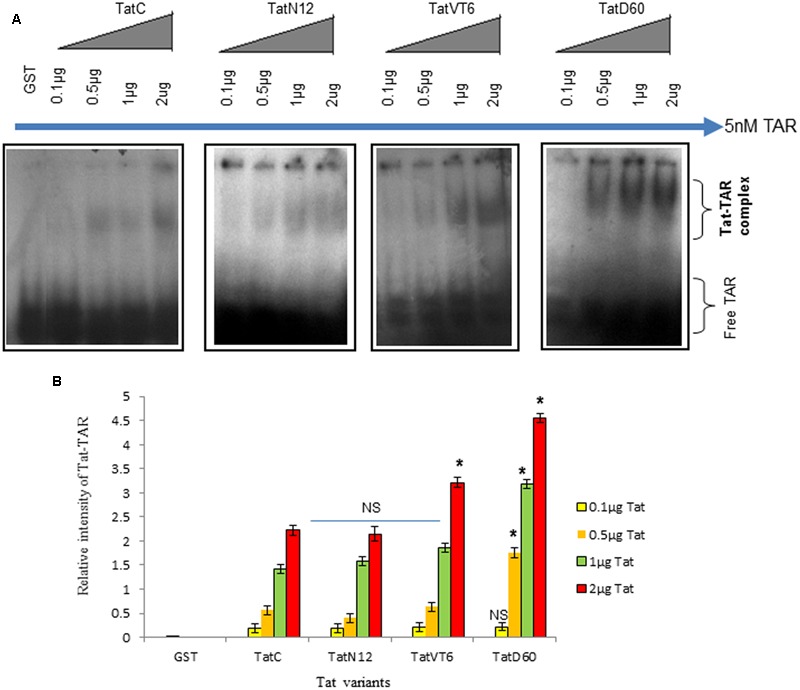
Tat–TAR interaction by EMSA. Tat variants and wild-type Tat cloned in pGEX-4T2 vector were expressed in BL21 (DE3) pLysS cells. Expressed Tat proteins were isolated and verified by immunoblotting with anti-Tat antibody. Increasing concentrations of purified Tat proteins were subjected to interact with subtype B TAR and these Tat ± TAR complexes were detected by autoradiography. The relative intensity of Tat variants–TAR complexes were measured using ImageJ software. Wild-type TatC–TAR complex was used as a reference Tat for comparison. GST was used as a control. Free TAR was used as a loading control. (A) Relative intensity of Tat variants–TAR complexes and wild-type TatC–TAR complex. (B) Quantification of Tat variants–TAR complexes normalized to empty vector. Error bar represents the standard deviation in triplicates. Statistical comparison of each Tat variant to Tat C was calculated by one-way ANOVA with the Tukey’s test (∗ denotes P < 0.05 and NS denotes not significant).